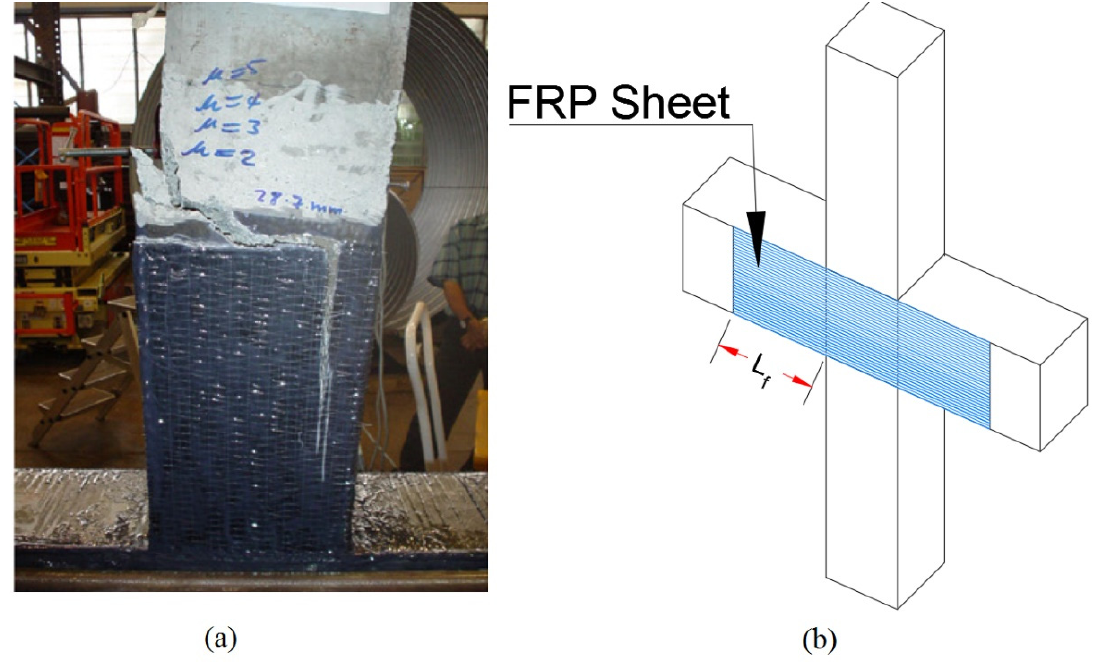
Figure 3. ( a ) Web ‐ bonding CFRP retrofitting system [26,27]. ( b ) Schematic scheme of web ‐ bonding Figure 3. ( a ) Web-bonding CFRP retrofitting system [26,27]. ( b ) Schematic scheme of web-bonding CFRP retrofit in an interior joint. CFRP retrofit in an interior joint.